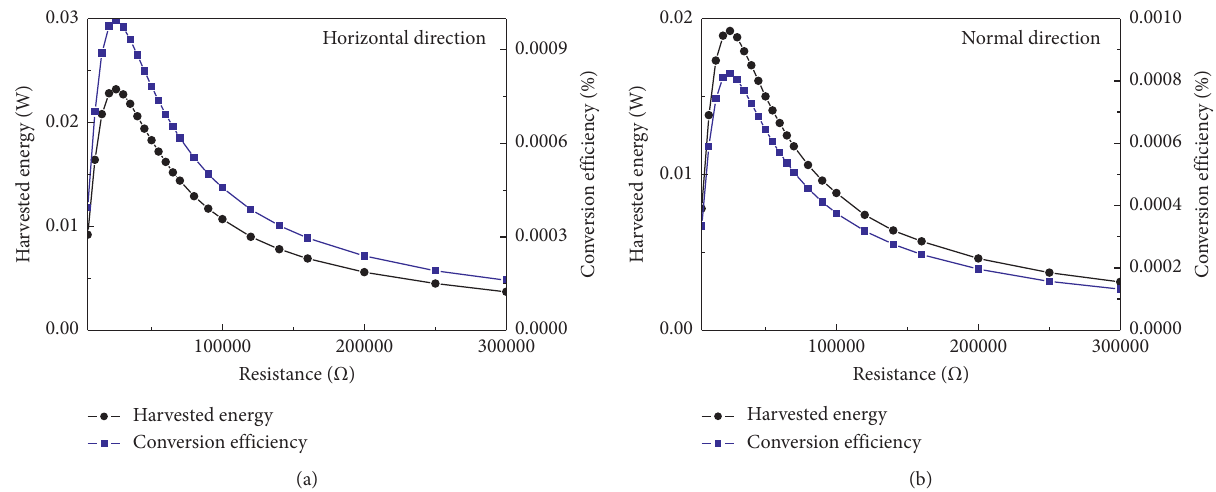
Figure 27: Ignoring separation, the harvested energy and conversion efficiency of the friction system in the horizontal direction (a) and normal direction (b) with different external electrical resistances.